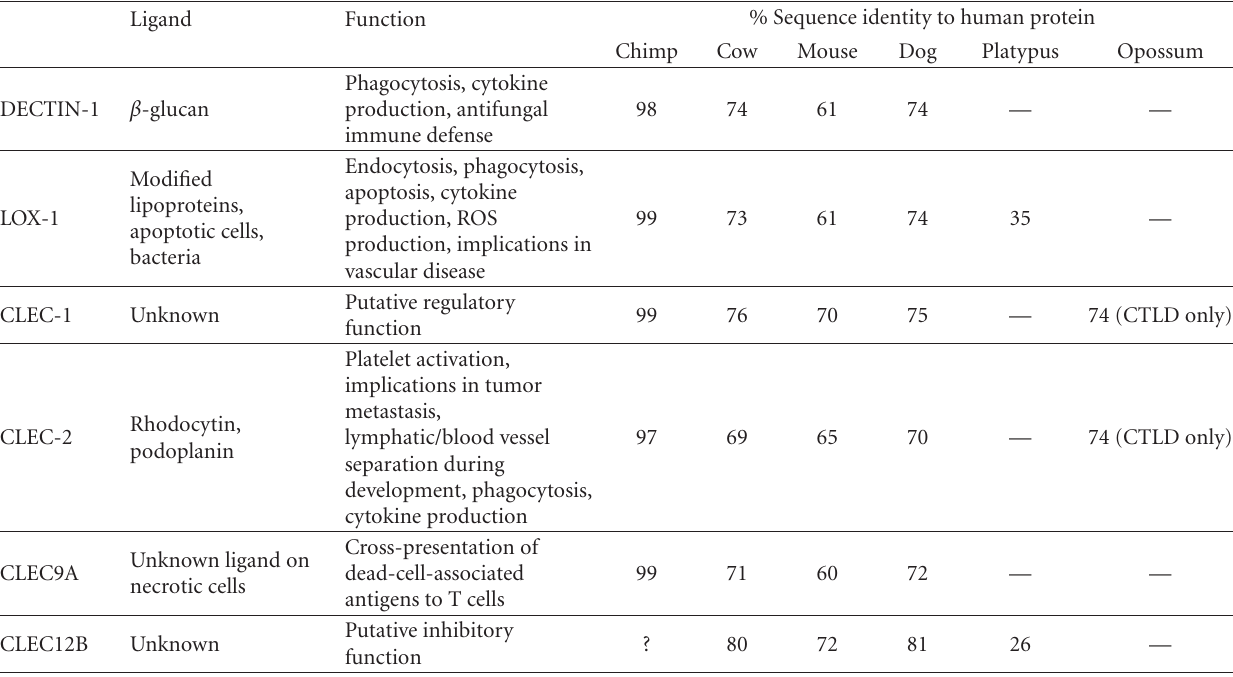
Table 2: Ligands, functions and protein sequence conservation of members of the DECTIN-1 cluster. Ligand